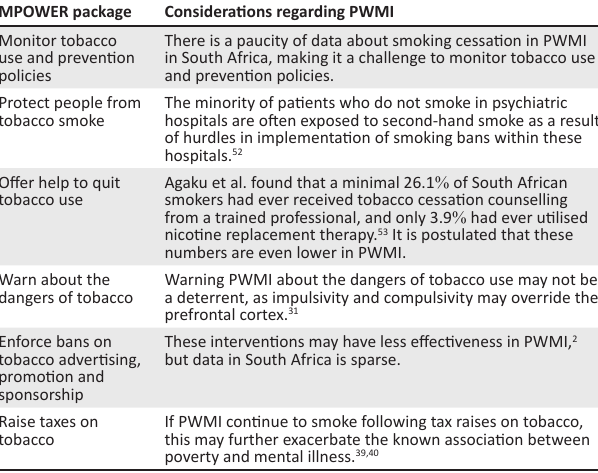
TABLE 2: MPOWER package and considerations among people with mental illness (PWMI). MPOWER